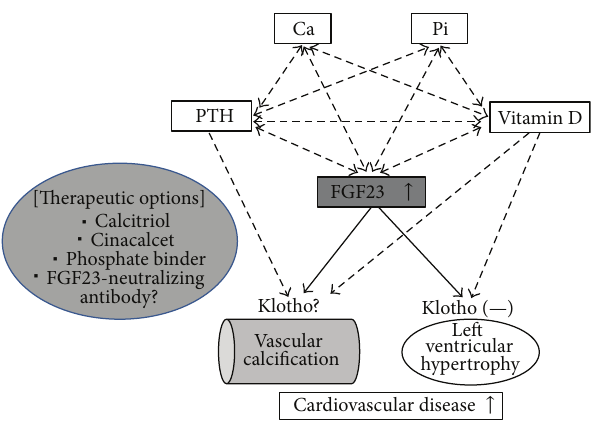
Figure 1: The role of FGF23 in the pathogenesis of cardiovascular disease in CKD-MBD. Ca: calcium; Pi: inorganic phosphate; PTH: parathyroid hormone; FGF23: fibroblast growth factor